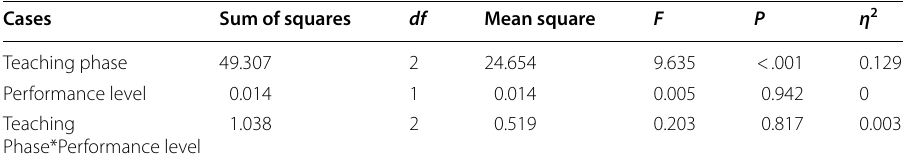
Table 3 Results of two-way ANOVA of average content access with teaching phase and performance